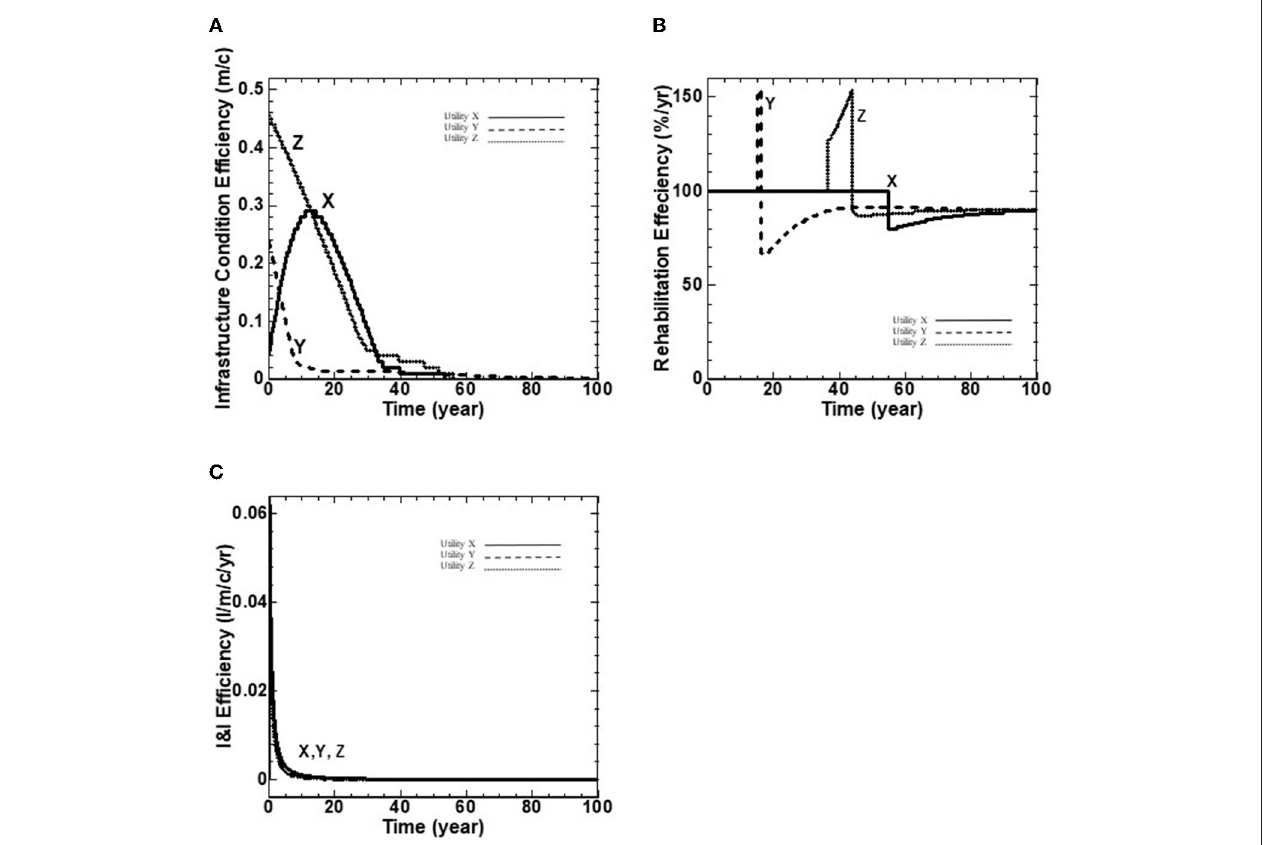
( Figure 2B ). For Utility Y, the rehabilitation efficiency starts with a value of 100 percent, climbs to 154 percent at 12 years due